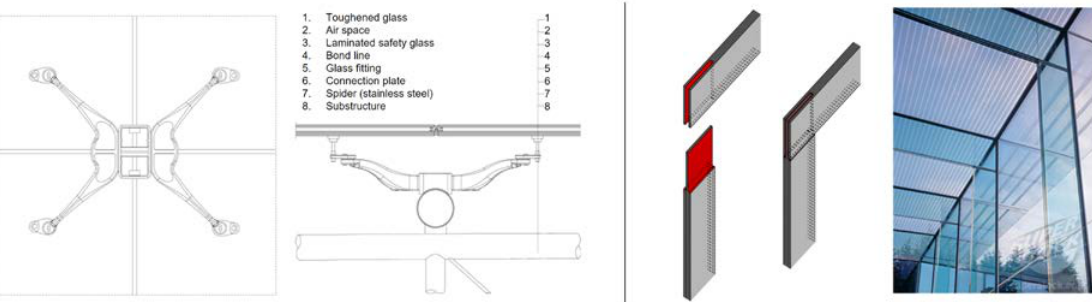
Fig. 3 Setup of an adhesively bonded glass fitting (left, Kuhlmann 2011), Principle sketch of the design of an adhesive bond between support and beam (middle, Eliášová 2015) and example of application Broadfield House Glass Museum in Kingswinford, UK (right, Eliášová 2015)